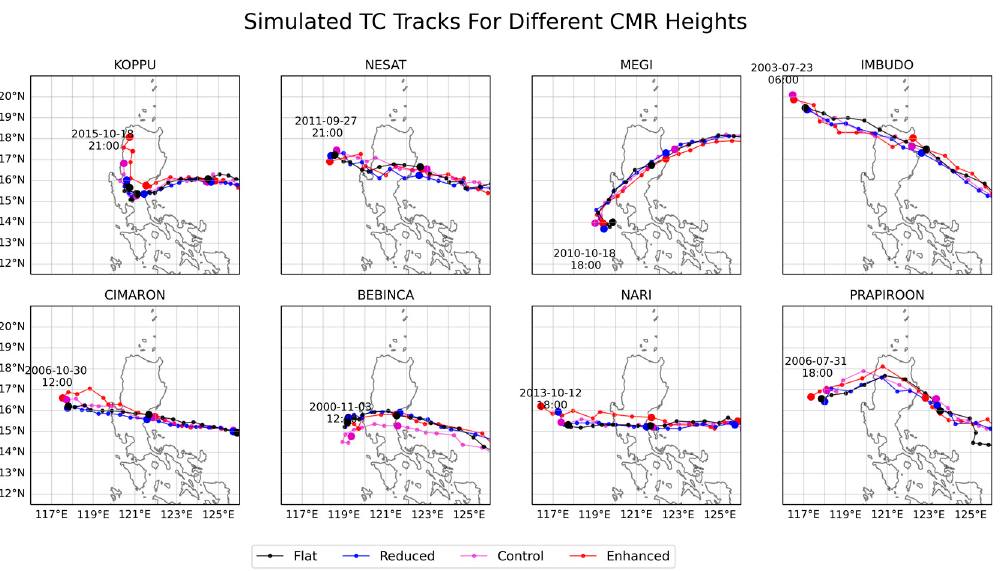
Figure 6. TC tracks for the different orography experiments: Flat (black), Reduced (blue), Control (magenta), and Enhanced (red). Tracks are plotted up to 24 h after landfall, with each 24 h period plotted in larger markers.